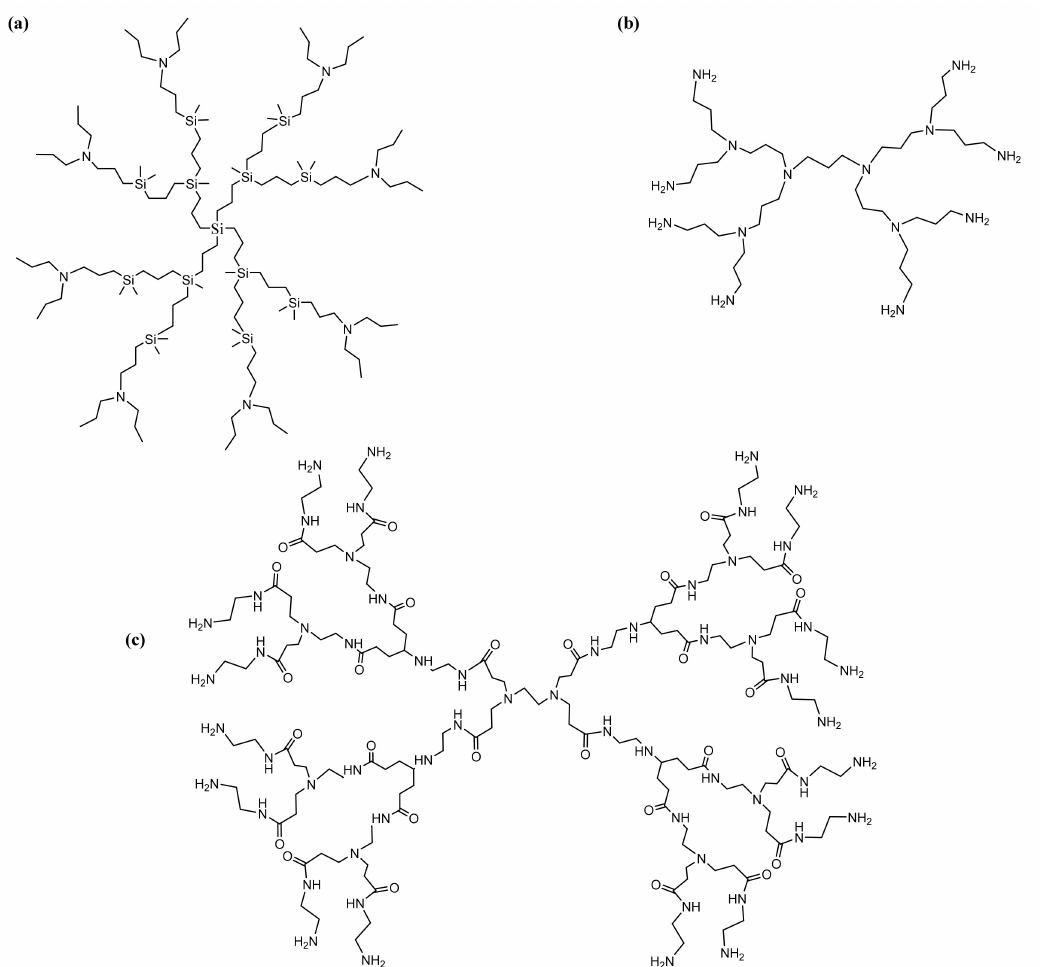
Figure 8. General structures of some G2 dendrimers: ( a ) carbosilane dendrimers; ( b ) polypropylene-imine dendrimers; ( c ) cationic poly(amidoamine) dendrimers, most commonly used to provide therapeutic nucleic acids. Adapted from [184], published by Pharmaceutics,